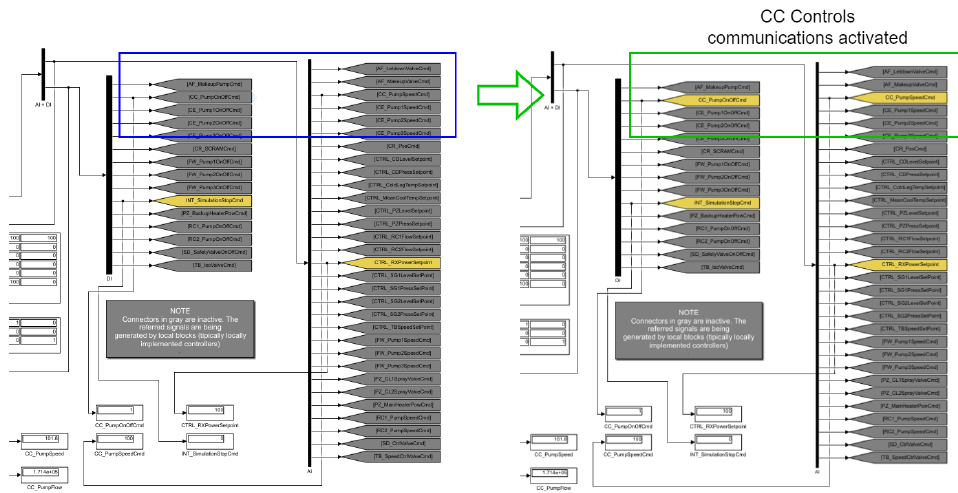
Figure 13. CC control variables communications